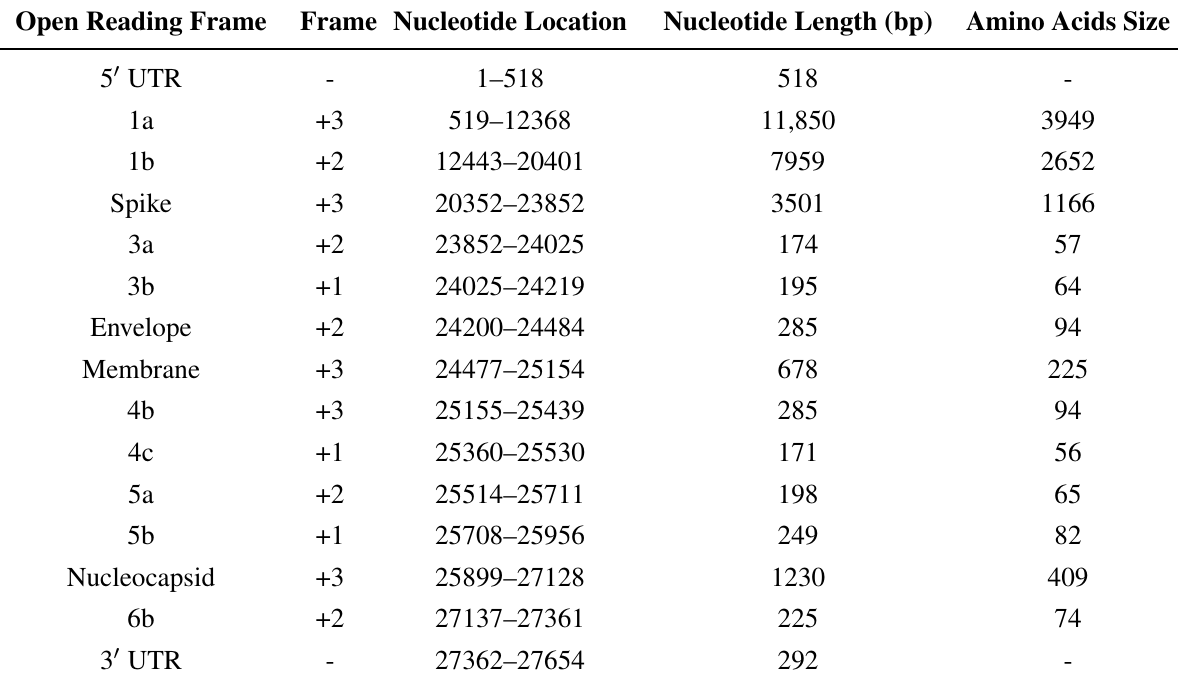
Table 1. Genes, coding regions, nucleotide length and amino acids size of B1648 strain. Open Reading